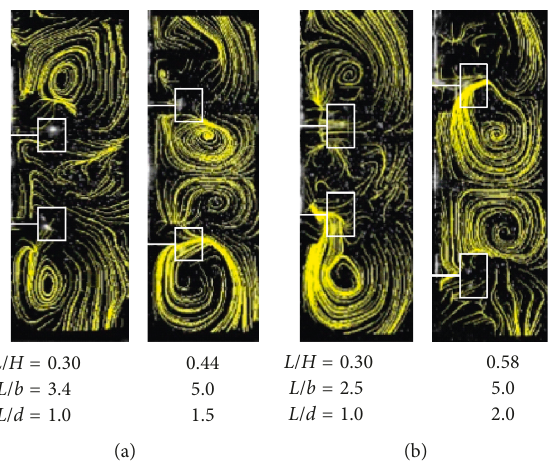
Figure 3: Effect of impeller blade height on flow between impellers.